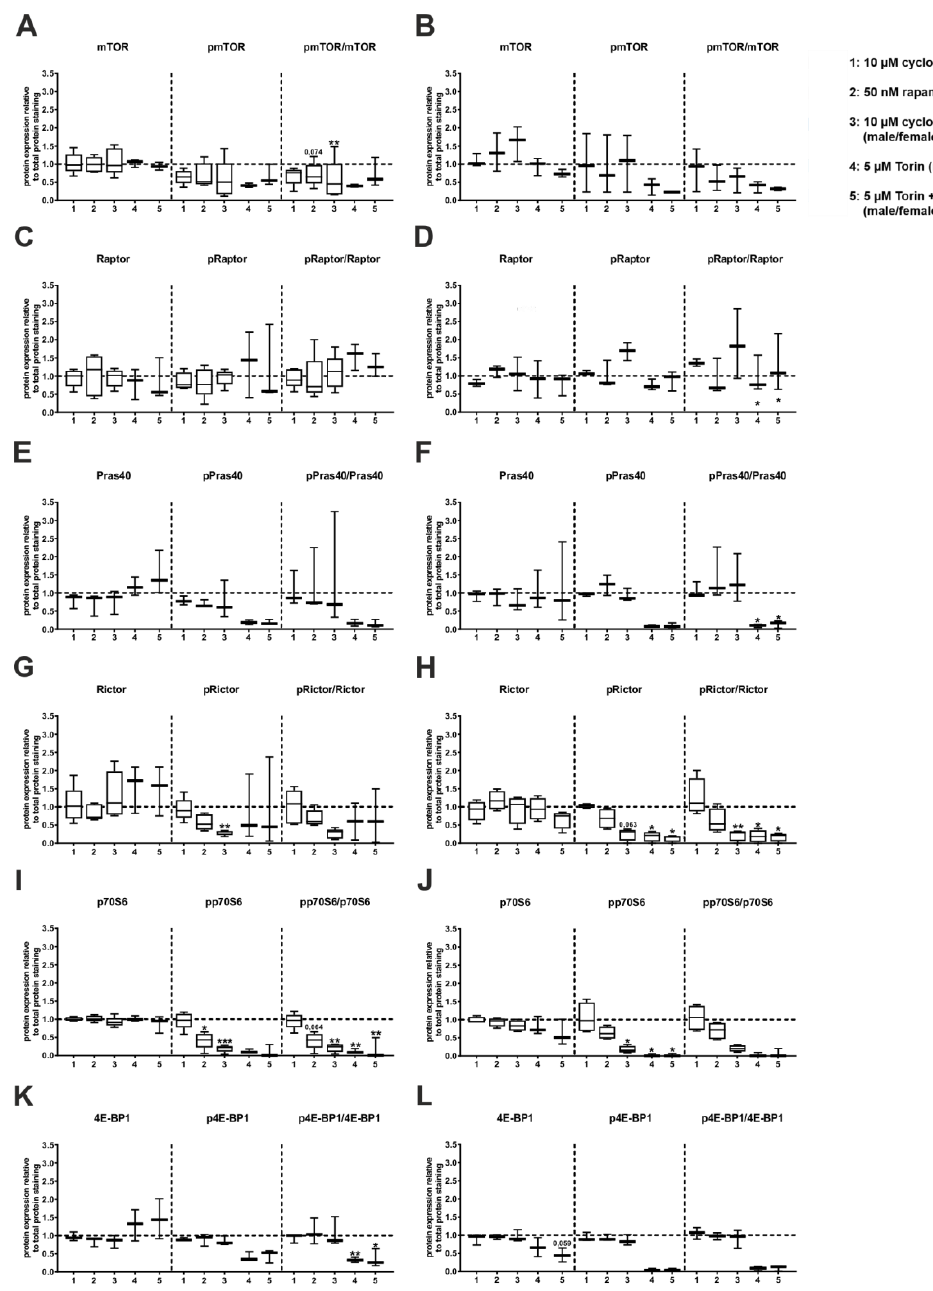
Figure 6. Protein expression and phosphorylation state of the mechanistic target of rapamycin (mTOR) signalling after inhibition of Hedgehog and / or mTOR signalling. Primary hepatocytes from C57BL / 6N mice were isolated and incubated for 24 h with 10 µ M cyclopamine, 50 nM rapamycin, 5 µ M Torin and combinations of them. ( A , L ): Densitometric evaluation of the band intensities of the Western blots normalized on the total protein staining, relative to DMSO control (dashed line). ( A , B ): mTOR and phosphorylated (p) mTOR (Ser2448) of male ( A ) and female ( B ) hepatocytes. ( C , D ): Raptor and pRaptor (Ser792) of male ( C ) and female ( D ) hepatocytes, ( E , F ): Pras40 and pPras40 (Thr246) of male ( E ) and female ( F ) mice. ( G , H ): Rictor and pRictor (Thr1135) of male ( G ) and female ( H ) hepatocytes. ( I , J ): p70S6 and pp70S6 (Thr389) of male ( I ) and female ( J ) hepatocytes. ( K , L ): 4E-BP1 and p4E-BP1 (Thr37 / 46) from male ( K ) and female ( L ) hepatocytes. Significance was calculated with one-way ANOVA for repeated measurements. Stars show the significance to Dimethyl sulfoxide (DMSO) control. * p ≤ 0.05, ** p ≤ 0.01, *** p ≤ 0.001; n = 3–5.